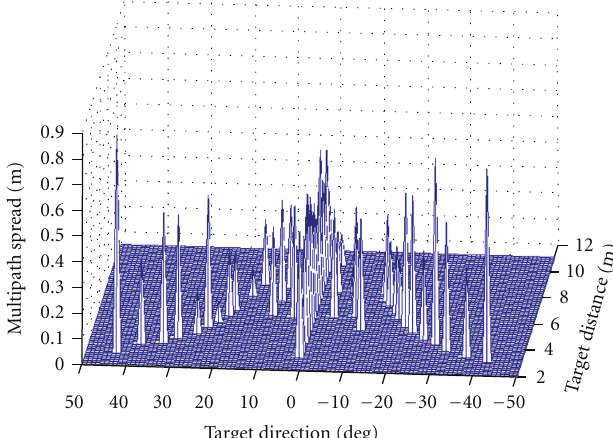
Figure 14: Multipath spread from a target vehicle in outdoor experiments.